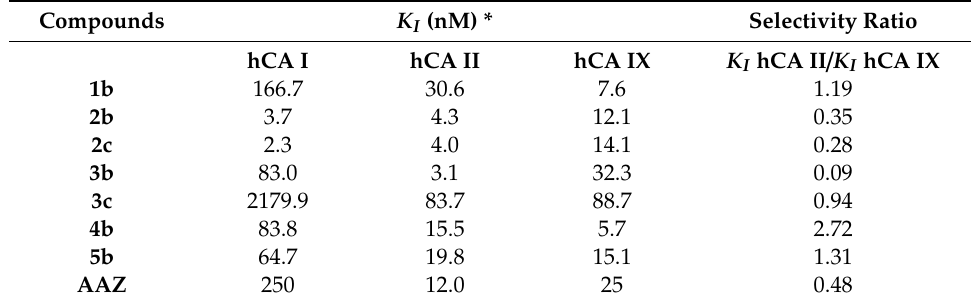
acetazolamide ( AAZ ), against hCA I, hCA II, and hCA IX using a stopped flow CO 2 hydrase